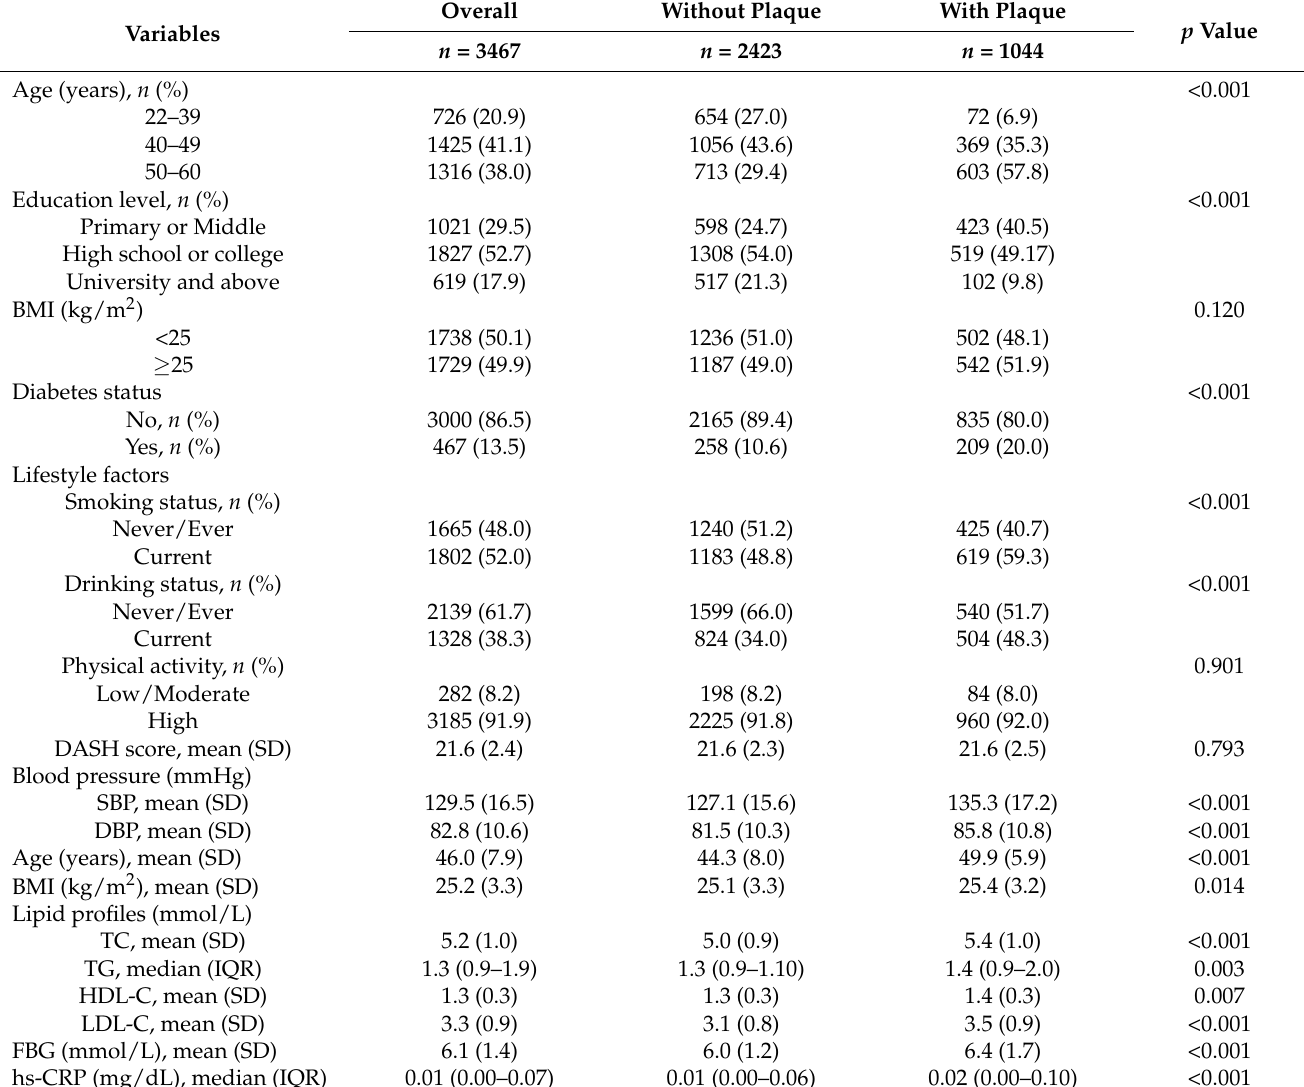
Table 1. Essential features based on carotid